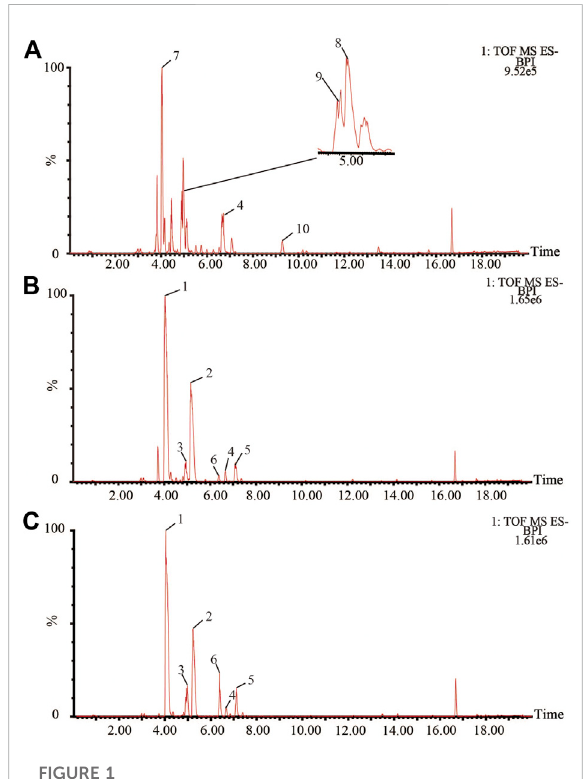
FIGURE 1 BPI chromatograms of bile (A) : pig bile; (B) bovine bile; (C) sheepbileinnegativeESImode.1TCA; 2TDCA;3GCA; 4GCDCA; 5 GDCA; 6 CA; 7 THDCA; 8 TCDCA; 9 GHDCA; 10